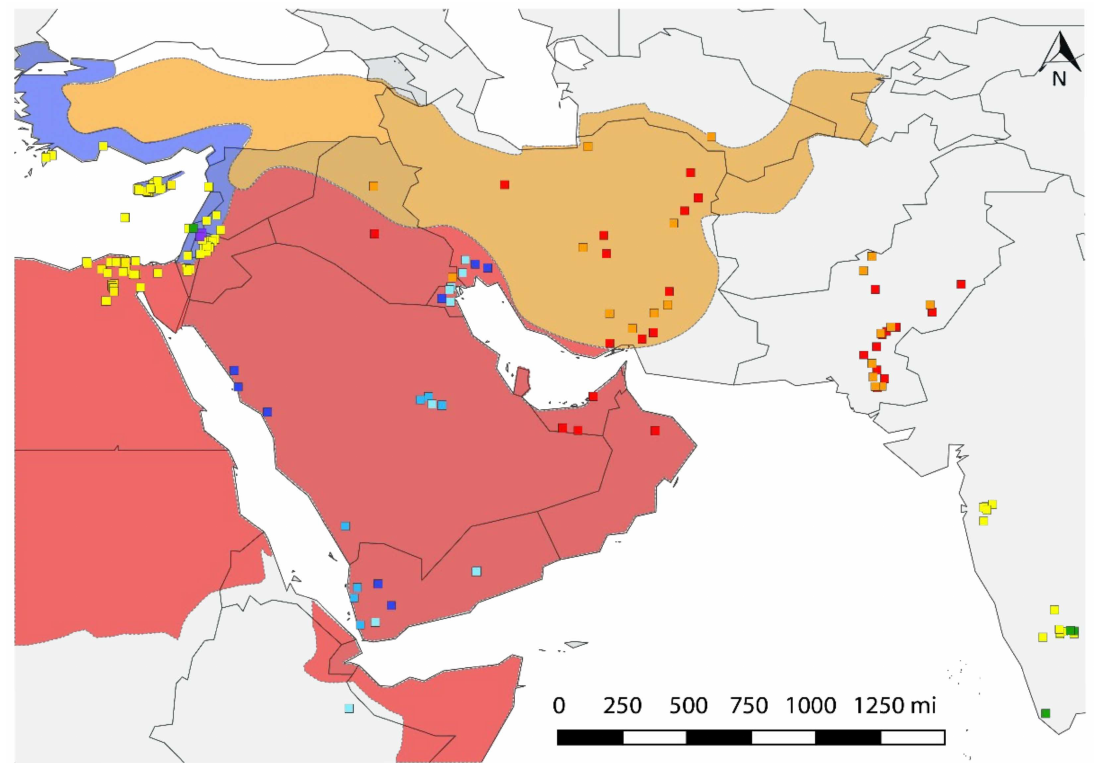
Figure 4. Distribution of haplotypes in ecological macro niches. Red area represents the hot desert climate (BWh) of the Arabian Peninsula and Northeast Africa. Orange shows the Irano-Turanian floristic region with semi-arid ecosystems (BSh, BSk). Blue indicates the eastern Mediterranean niches (Csa). NAFME 1–3 inhabit desert habitats, NAFME 4 and 5 are native to the semi-arid regions, while NAFME 6 and 7 inhabit only those locales in the Middle East with a Mediterranean-like climate, and NAFME 8 occupies both locales in the western Mediterranean-deserts of Israel and desert habitats in Egypt where irrigated agriculture has long been practiced, e.g., the Red Sea